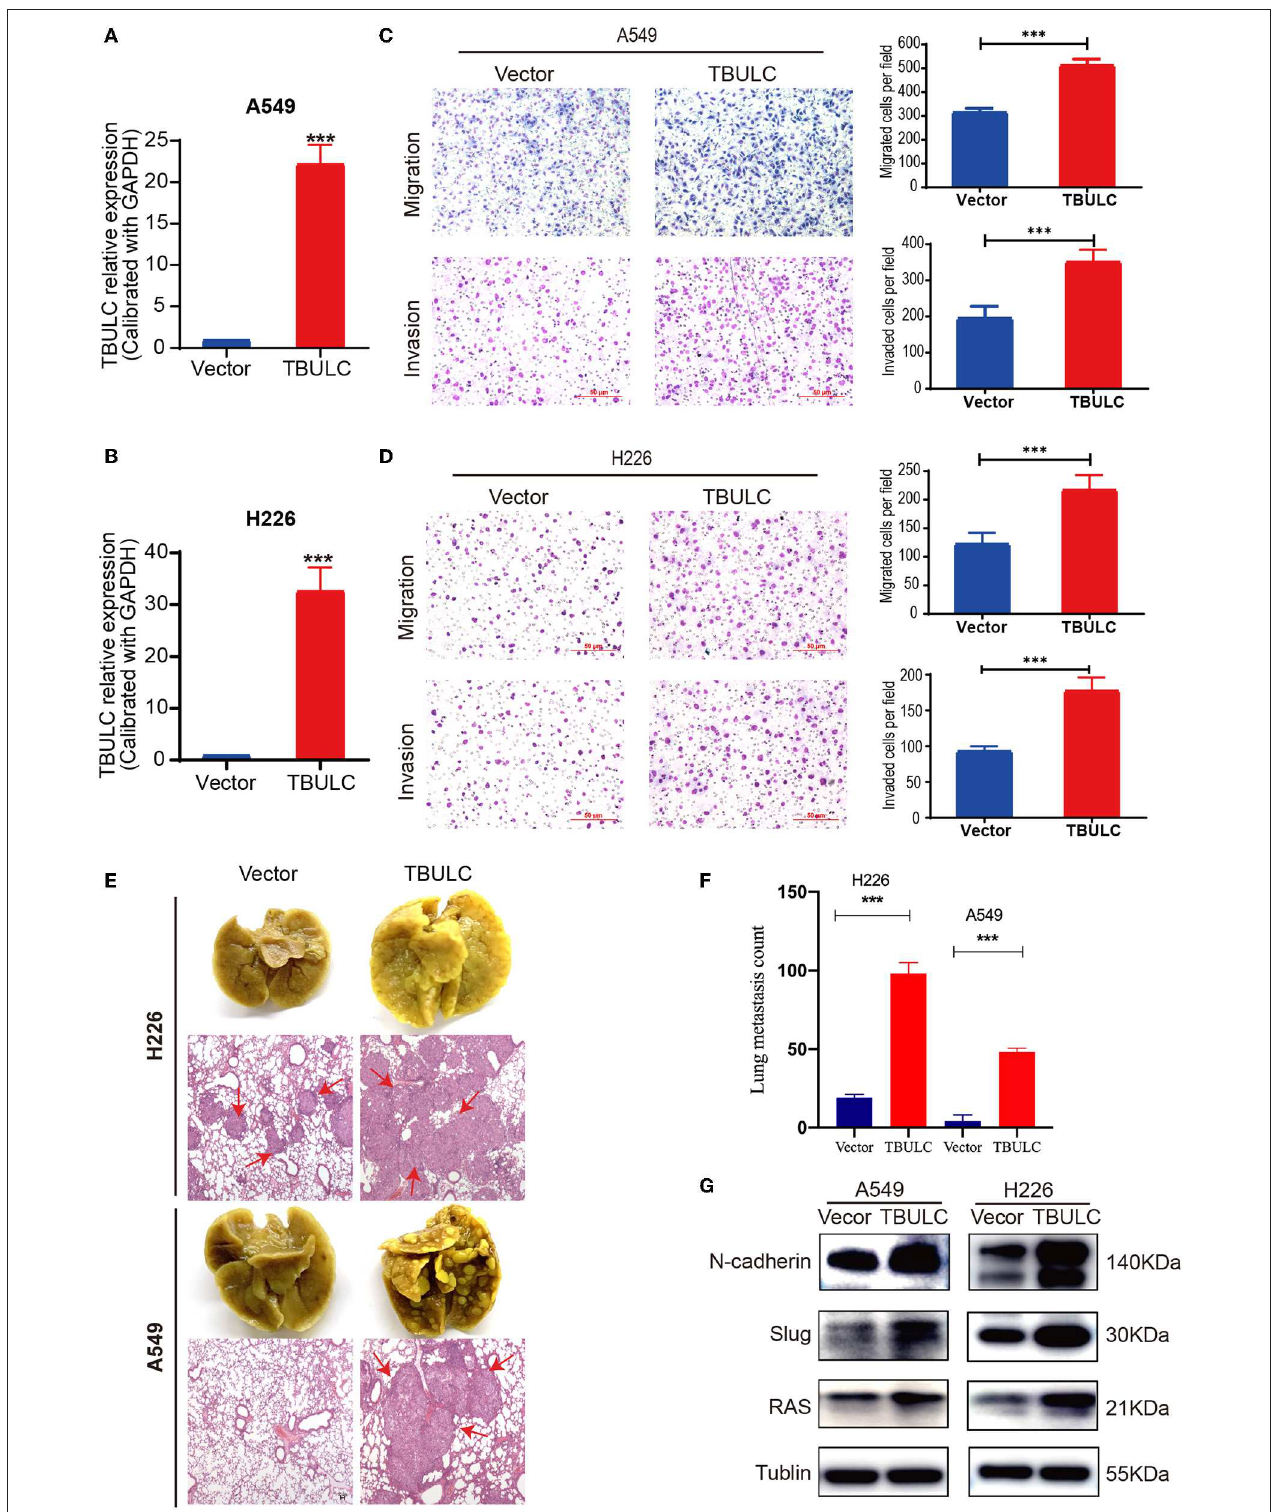
FIGURE 3 | TBULC overexpression promoted cell migration and invasion in vitro and in vivo . (A,B) The expression level of TBULC in stable TBULC overexpression or mock vehicle control-transfected (A) A549 and (B) H226 cell clones. (C,D) The migration and invasion ability of TBULC-overexpressing (C) A549 and (D)